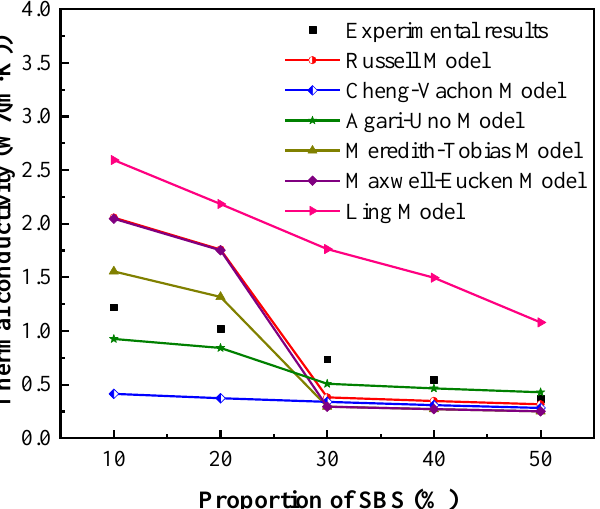
Figure 11. Theoretical and experimental thermal conductivities of composite flexible PCMs at 12.5 ◦ C. The equations of Russell Model, Cheng-Vachon Model, Agari-Uno Model, Meredith-Tobias Model, Maxwell-Eucken Model, Ling Model are from [25–27,37–39], respectively.